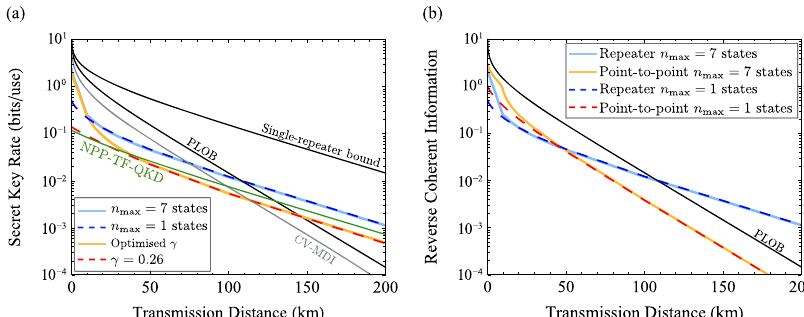
Fig. 2 Simulation results of our repeater protocol for a pure-loss channel with a loss of 0.2 dB/km. a Solid orange and red dashed lines show the key rates of our protocol using the states shown in Eq. (1) with n max ¼ 7 photons with optimised squeezing coef fi cients and a squeezing coef fi cient of γ = 0.26, respectively. Blue dashed line shows the results of the optimised states with n max ¼ 1 photon given in Eq. (2) and (3) and using Charlie ’ s POVM with an outcome of 1 and 2 photons. The solid blue line shows our protocol using the optimised states with n max ¼ 7 photons given in Eq. (2) and (3). Black solid lines show the single-repeater and repeaterless bounds. Solid grey line represents the CV- MDI protocol 30 with a variance of 1000 and relay positioned at 0.01 m away from Alice, while the solid green line shows the TF-QKD protocol with no phase post-selection (NPP-TF-QKD) 60 using optimised coherent states and in fi nite decoy states. b The comparison of the reverse coherent information of the optimised states with n max ¼ 7 and n max ¼ 1 photons in the form of Eq. (2) and (3) in point-to-point communications between Alice and Bob and with a single-repeater. The faint blue and orange lines represent the RCI of the single-repeater and point-to-point communications of the optimised states with n max ¼ 7 photons correspondingly, while the blue and red dashed lines show the RCI of the single-repeater and point-to-point communications of the optimised states with n max ¼ 1 photon. The black solid line shows the reverse coherent information of an in fi nitely squeezed TMSV state denoted as